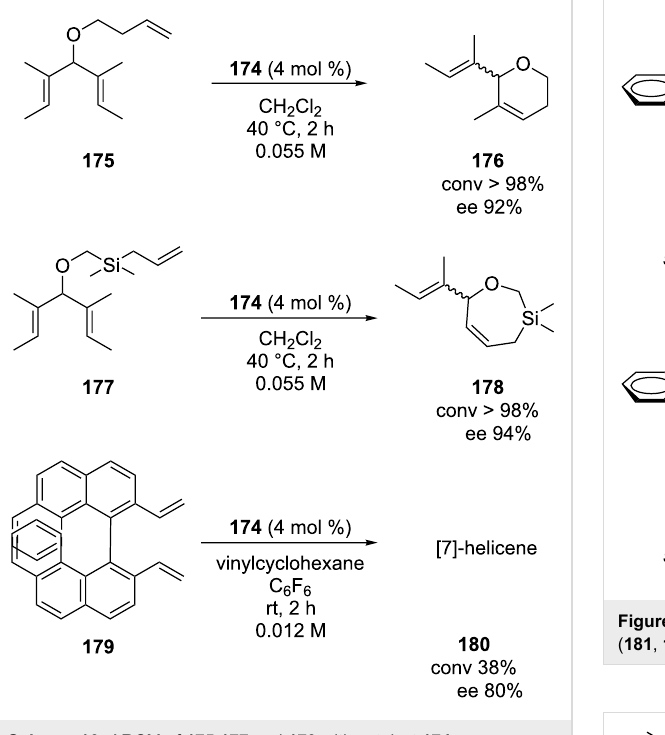
Scheme 16: ARCM of 175 , 177 and 179 with catalyst 174 .